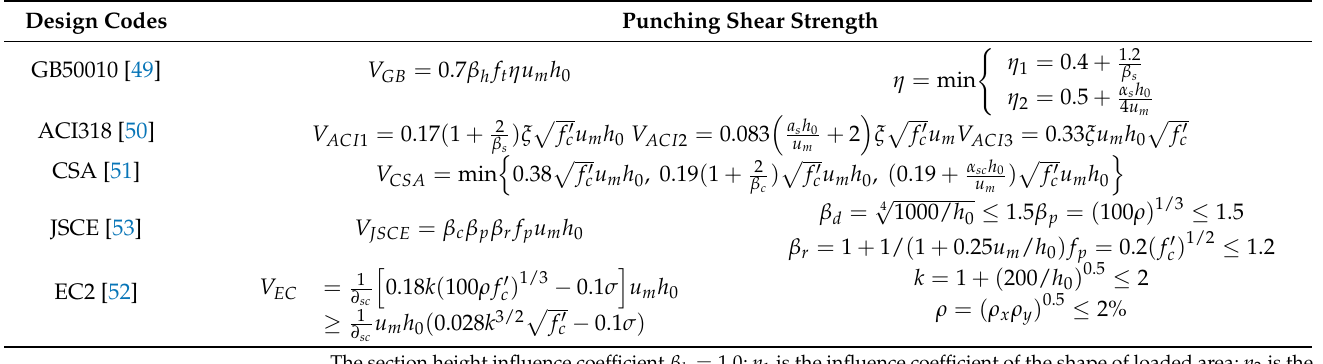
Table 1. Design codes for punching shear resistance.